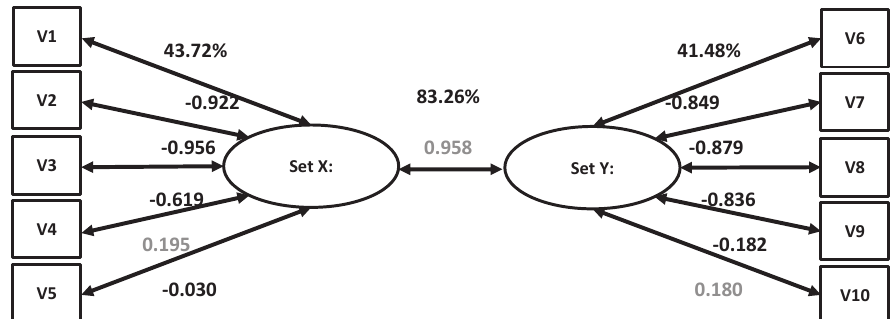
Fig. 3 – Summary of canonical correlation relations. Source: own